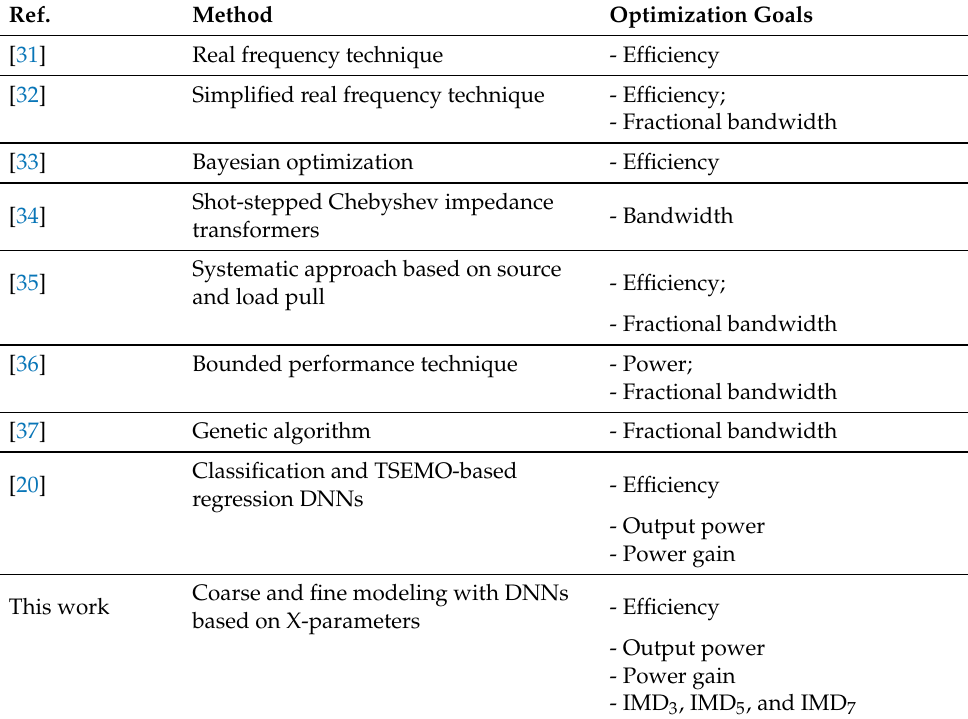
Figure 10. Measured output spectrum with 20 MHz LTE signal having 10.7 dB PAPR, with and without DPD. Table 2. Summary of various methodologies and the optimization goals.